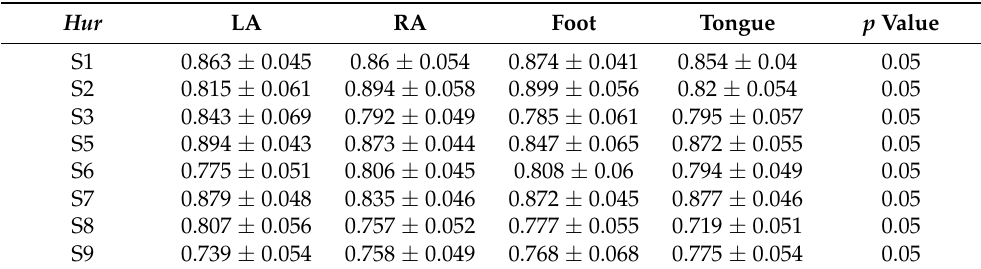
Table 3. The average values (mean ± SD) of Hur to estimate the MI-BCI performance from four classes (left hand, right hand, feet, and tongue) of eight subjects